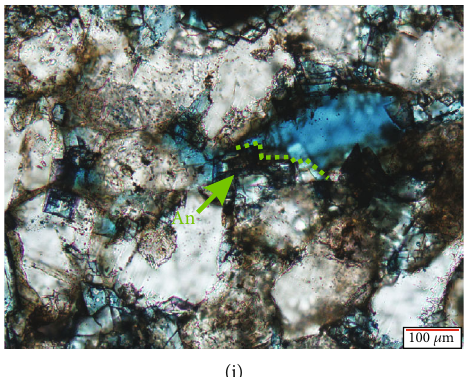
Figure 4: Photomicrographs of carbonate cements, dissolved feldspars and secondary minerals in thin sections. (a) F1, 3321.5m: the dissolution of calcite and feldspar with the precipitation of secondary quartz; (b) F25, 2998.5m: the leached feldspar and associated secondary minerals; (c) G351, 2444.5m: feldspar dissolution and Fe-calcite and ankerite precipitation; (d) G351, 2447m: the leached feldspar and associated secondary minerals, and the secondary intragranular pore is destroyed by ankerite precipitation; (e) F1, 3314.6m: the precipitation of secondary quartz mineral with a width of approximate 40 μ m; (f) F104, 3038.9m: the leached feldspar and associated quartz overgrowths; (g) G891, 2808.4m: early calcite cement and late ankerite cement; (h) G351, 2444.5 m: the dissolution of calcite and feldspar accompanied by clay minerals, and ankerite cement; (i) F1, 3319.1m: the intergranular pores are destroyed by ankerite cements. Note: Qo: quartz overgrowth, R: rock fragment, Fd: feldspar dissolution, Cc: calcite, Fc: ferrocalcite, and An: